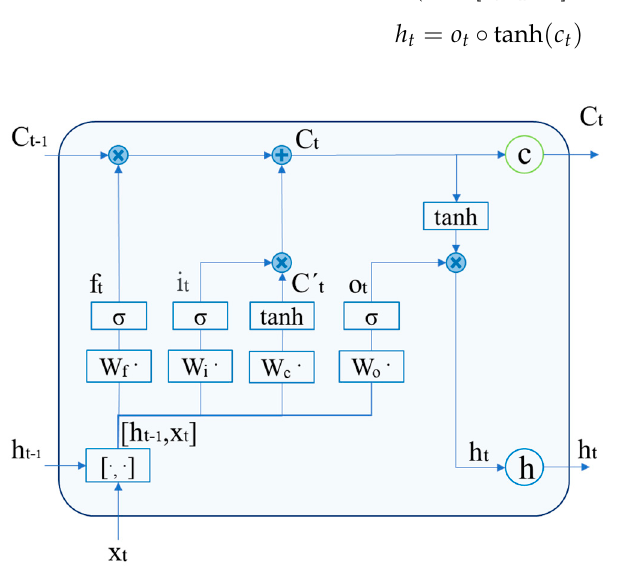
Figure 1. The long short-term memory (LSTM)